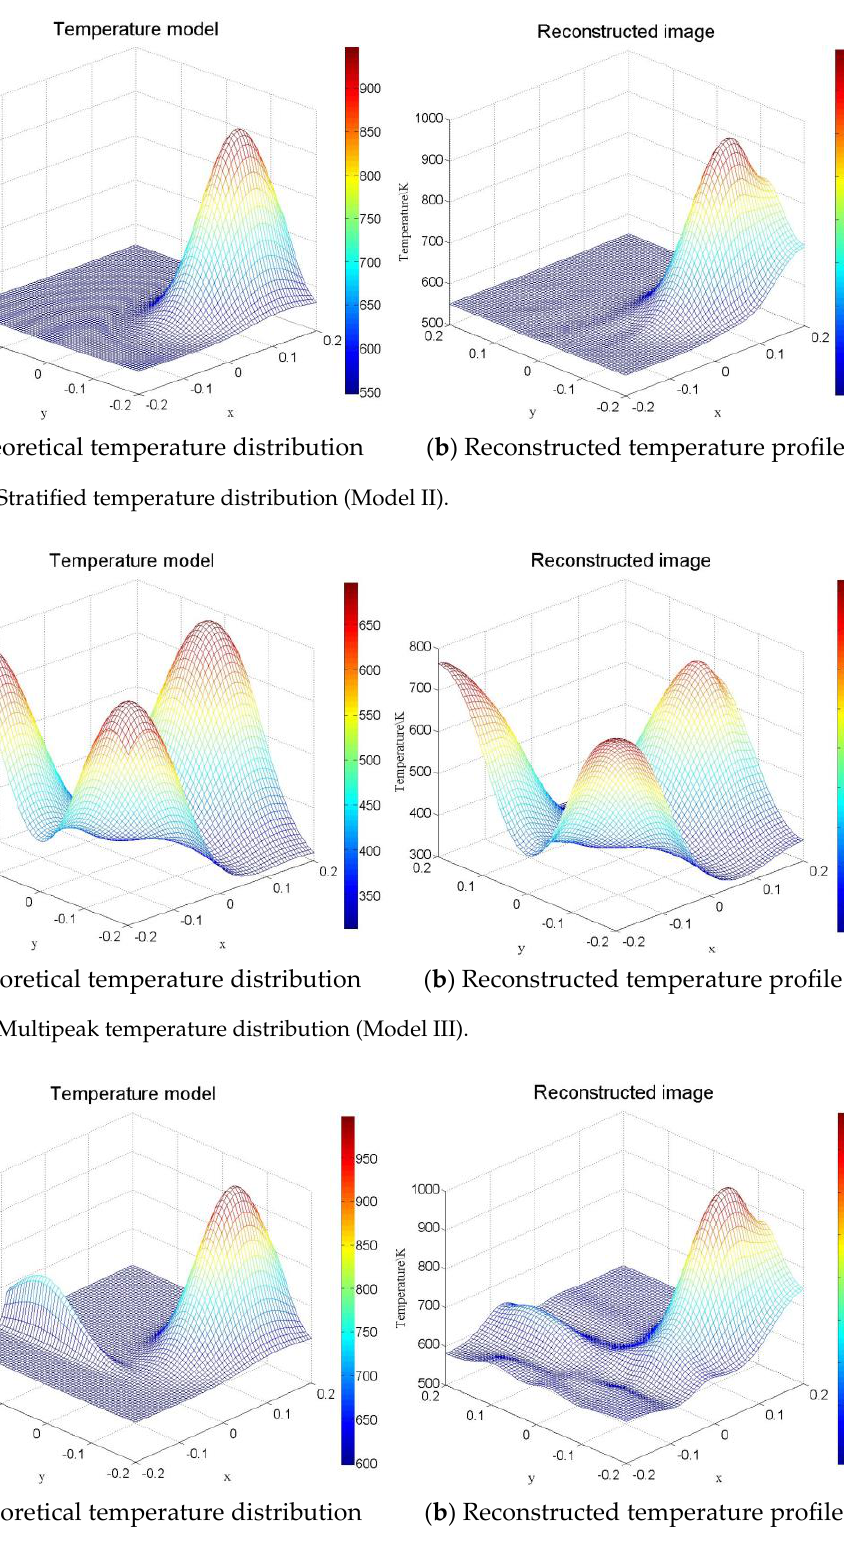
Figure 8 . Hybrid temperature distribution (Model IV). Figure 8. Hybrid temperature distribution (Model Table 3. Comparison of the errors in four models.